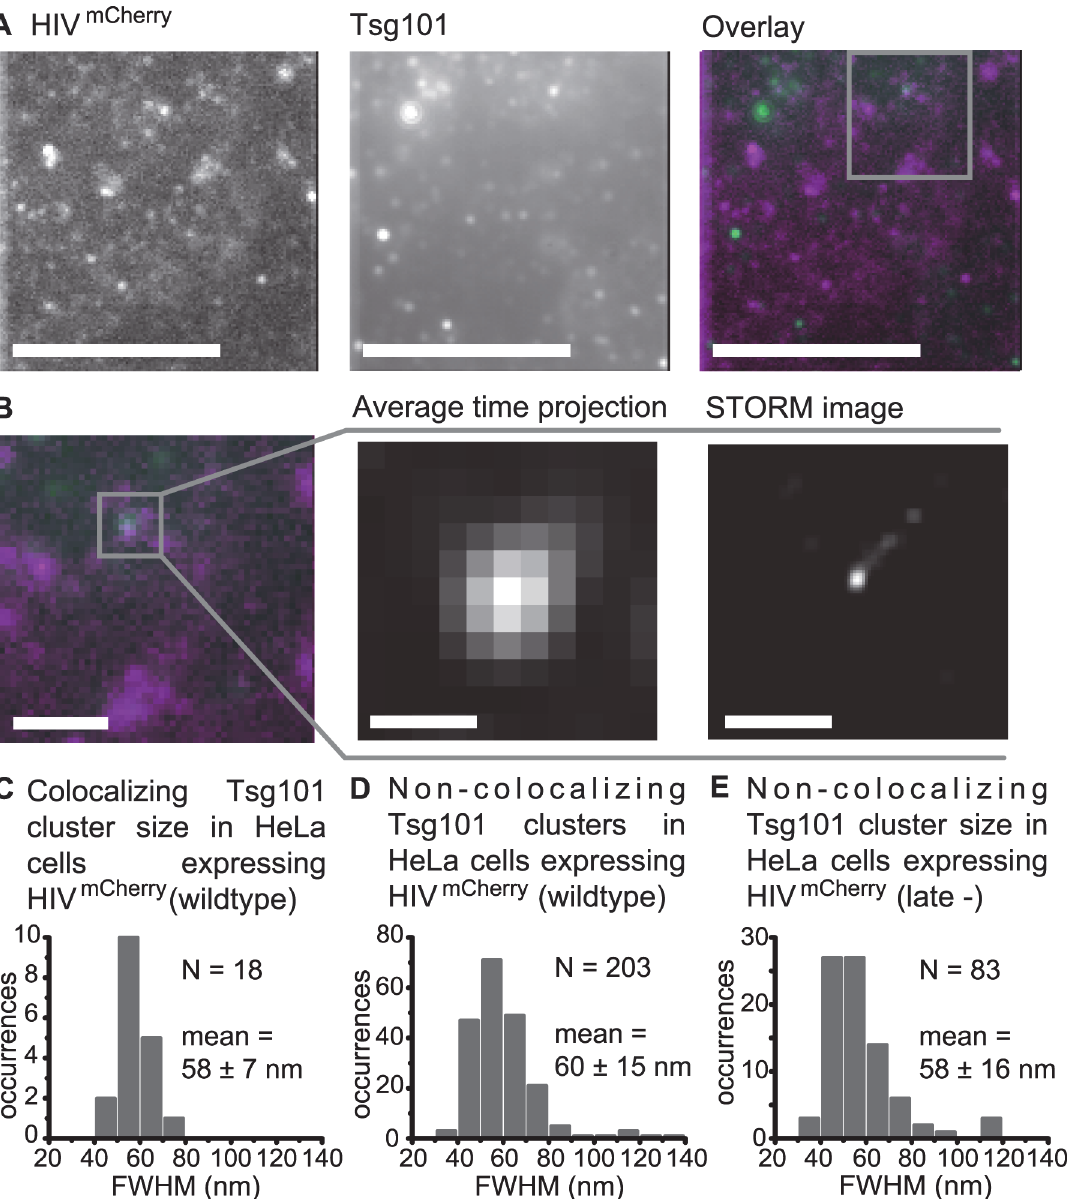
Fig 2. Super-resolution images of Tsg101 at HIV-1 assembly sites. HeLa cells were transfected with HIV:HIV mCherry and endogenous Tsg101 was immunostained at 14 – 15 h post transfection. ( A ) Cells were imaged using TIRFM. A time projection of the TIRFM images are shown (HIV mCherry , left panel ; Tsg101, middle panel ; Overlay, magenta: HIV mCherry , green: Tsg101, right panel ), scale bars: 10 μ m. ( B ) Left panel . A zoomed image of the region highlighted in panel A . Scale bar: 2 μ m. Middle panel . A zoomed image of the individual colocalizing Tsg101 cluster highlighted in the left panel. Scale bar: 500 nm. Right panel . A drift-corrected STORM image of the Tsg101 complex shown in the middle panel. Scale bar: 500 nm. ( C ) The size distribution of all Tsg101 structures colocalizing with HIV mCherry , revealing an average cluster size of 58 ± 7 nm. ( D ) Size distribution of all non-colocalizing Tsg101 clusters in cells expressing HIV mCherry revealing an average cluster size of 60 ± 15 nm or ( E ) or in cell expressing HIV mCherry late- revealing average cluster size of 58 ± 16 nm. Number N represents the number events contributing to the respective histogram. 18 Tsg101 clusters were found to colocalize with HIV-1 assembly sites, corresponding to a coloca- lization percentage of 1.8% with respect to all detected assembly sites. To verify that the low num- ber of colocalizations is not due to inefficient labeling of the epitope, we performed experiments